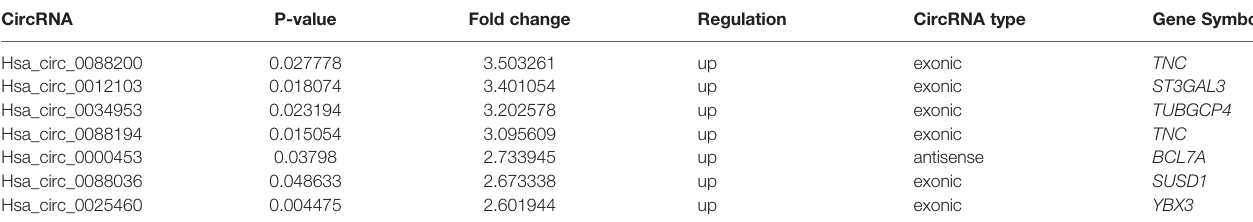
TABLE 2 | Microarray analysis of dysregulated circRNAs in three RA patients compared with three OA patients.